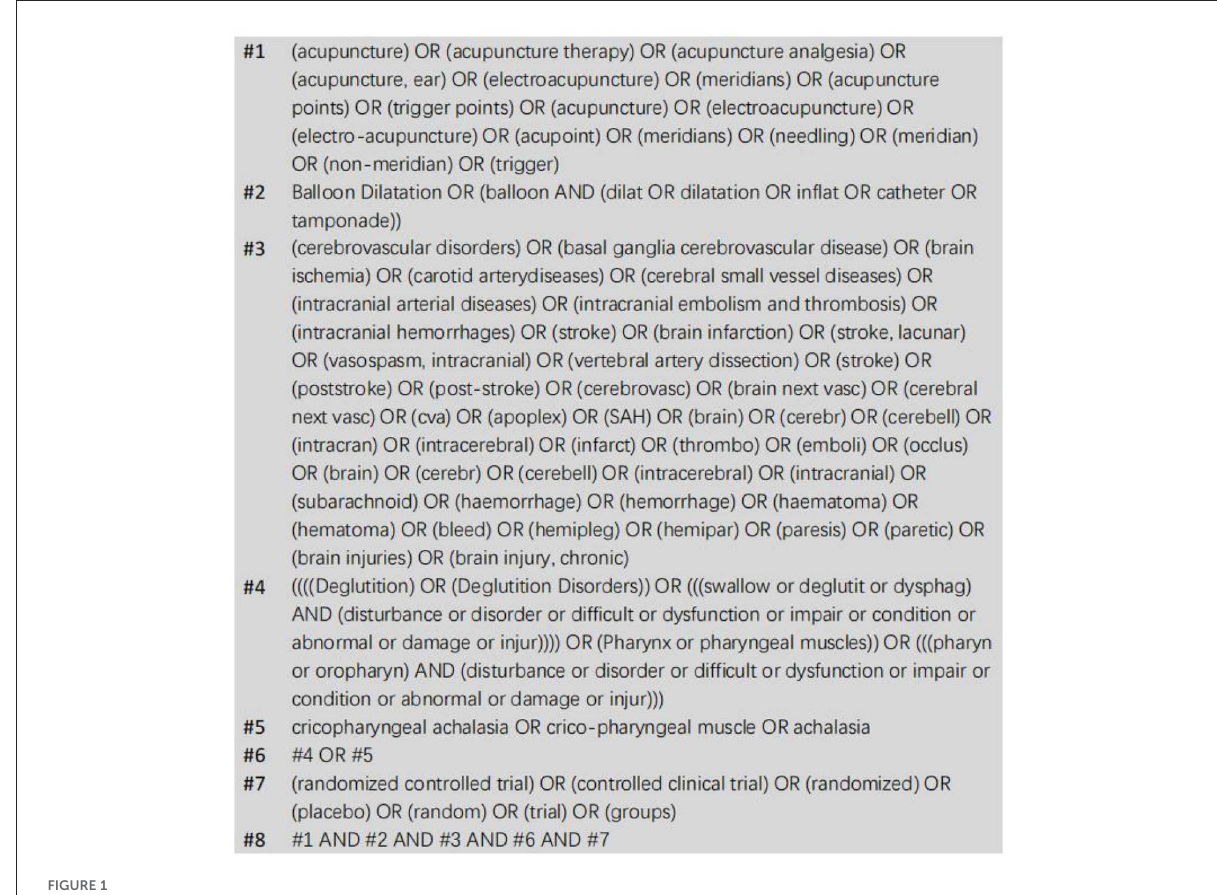
FIGURE1 PubMed retrieval